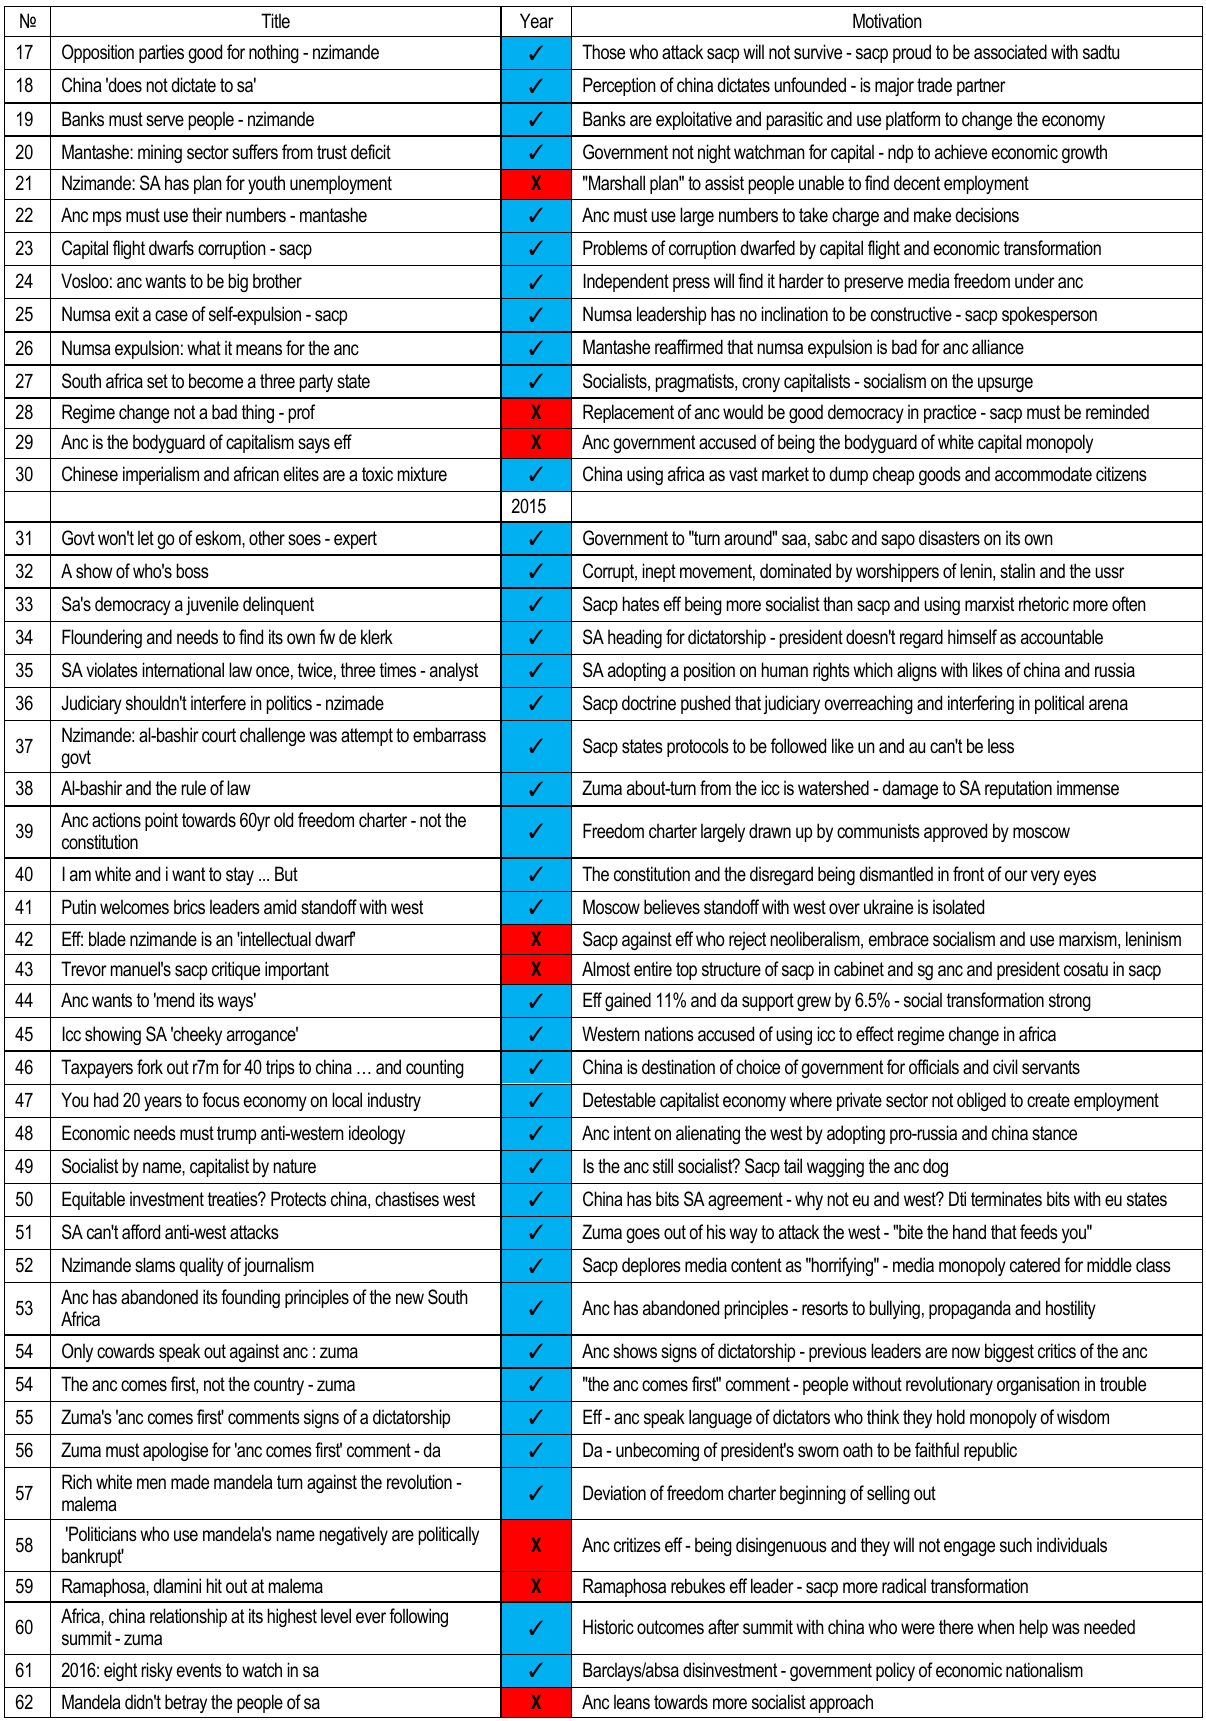
Table 2 (cont.). Movement towards socialism/communism of BEE (January 2014-January